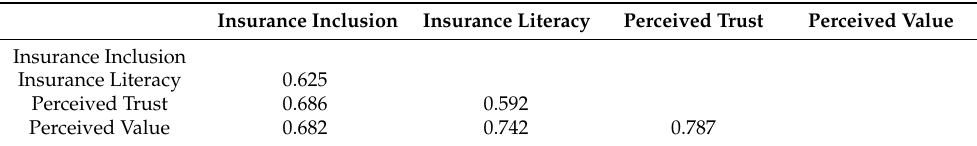
Table 2. Discriminant validity-Heterotrait Monotrait (HTMT)